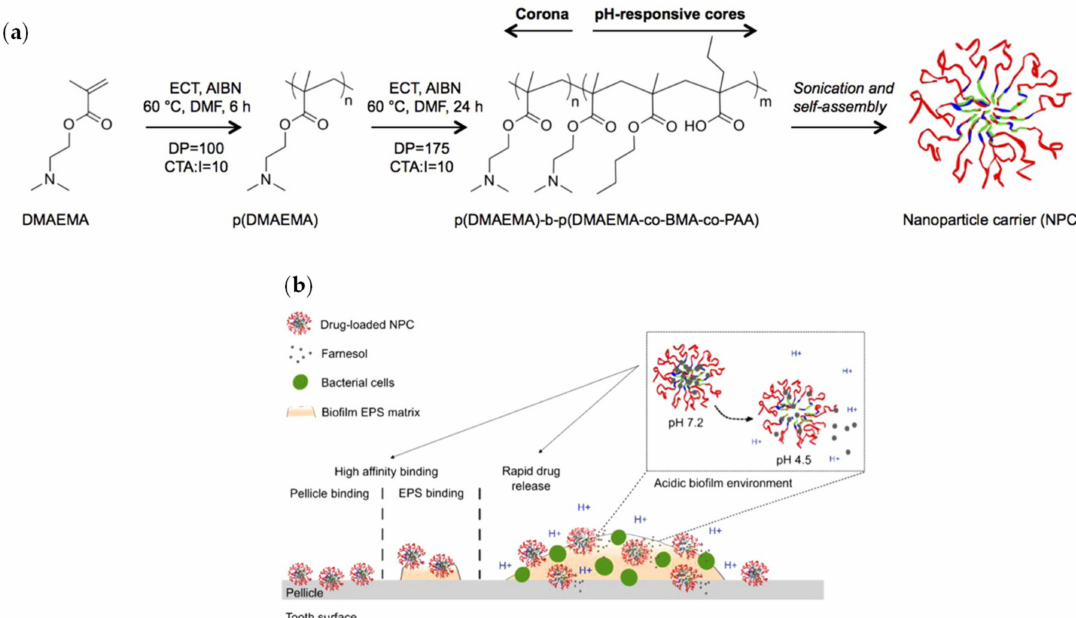
Figure 2. ( a ) Illustration of the chemical synthesis and self-assembly of the di-block copolymers used in the work of Horev et al. ( b ) Proposed mode of action of pH-responsive NPs for prevention and/or treatment of biofilms. PDI: polydispersity index; ECT: chain transfer agent (CTA), 4-cyano-4-[(ethylsulfanylthiocarbonyl)sulfanyl]pentanoic acid; AIBN: initiator, 2,2-azobisisobutyronitrile; DMF: dimethylformamide; DP: degree of polymerisation. Adapted with permission from Horev et al.